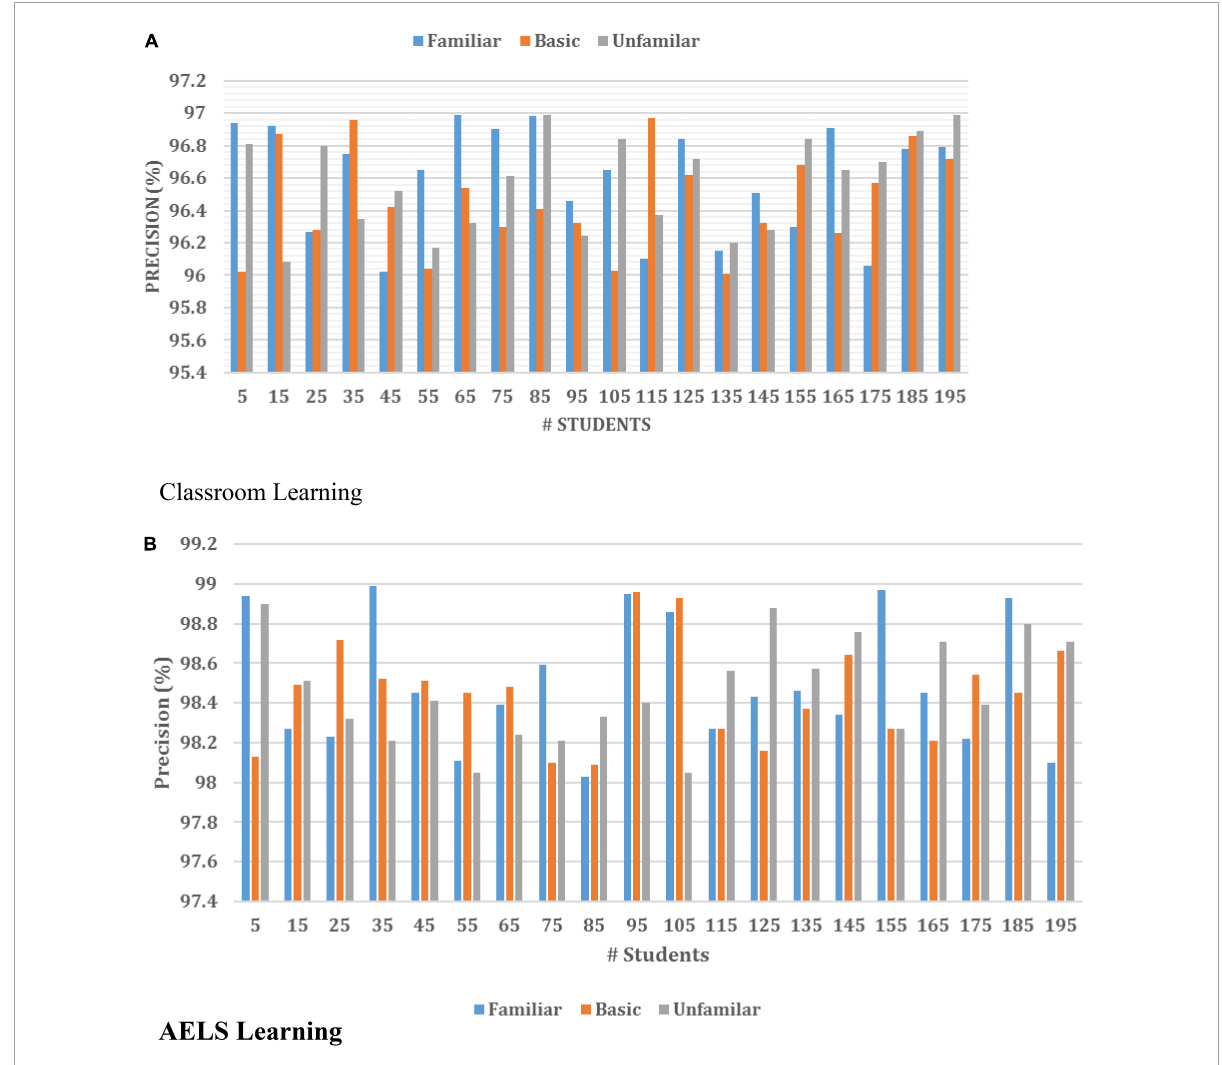
FIGURE7 Precision analysis of (A) classroom and (B) AELS